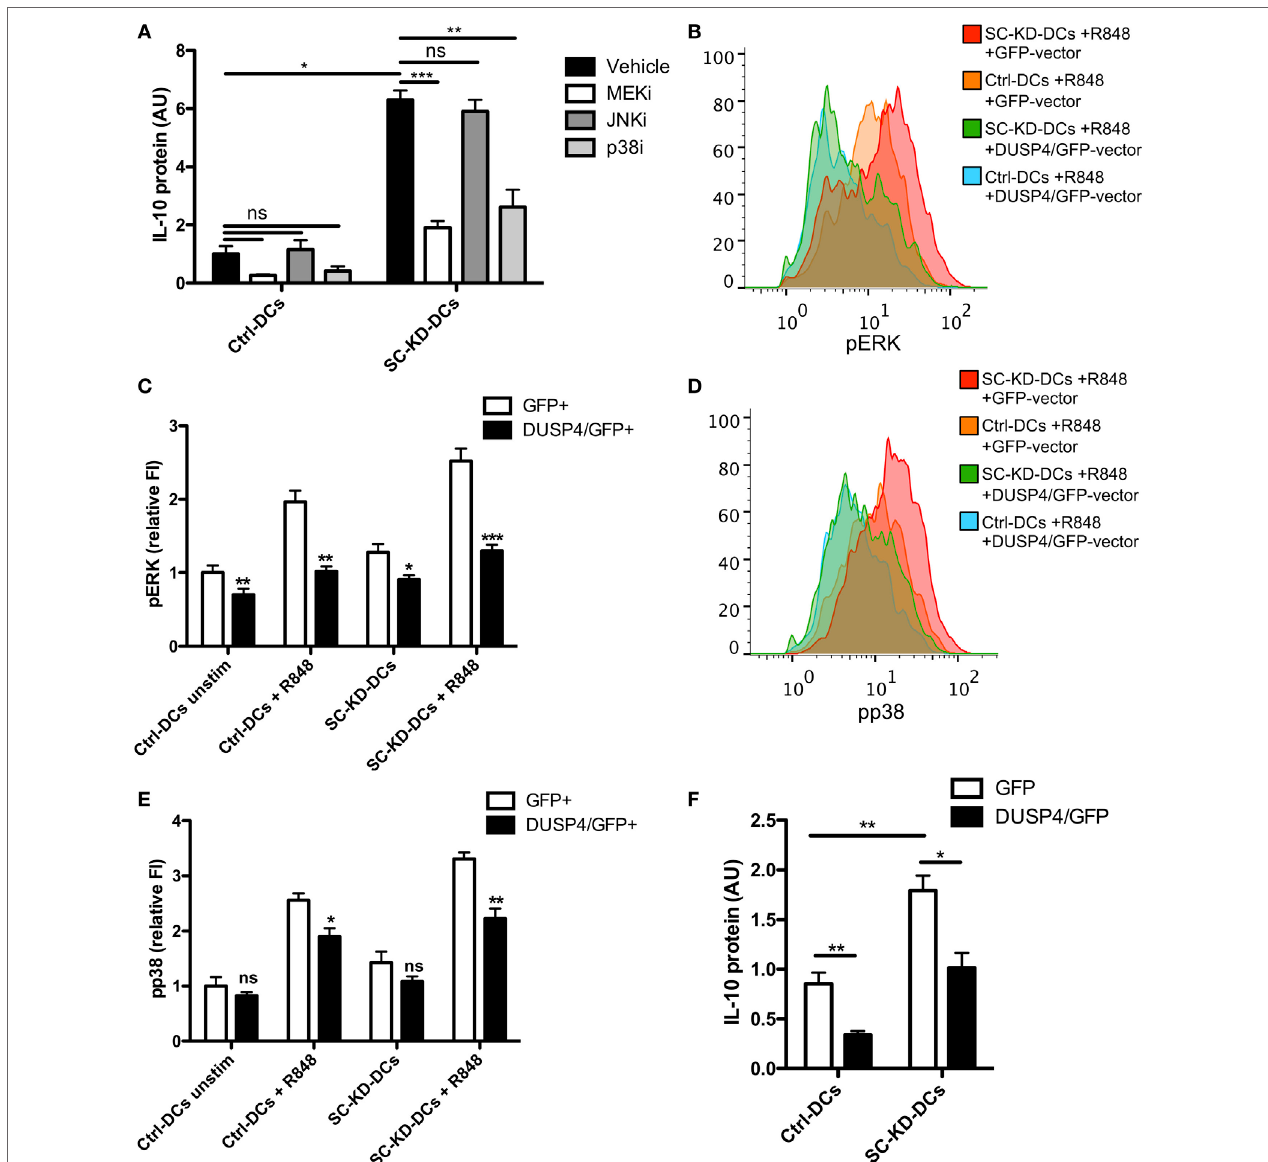
FigUre 4 | DUSP4 expression prevents the DC-SCRIPT-knockdown-mediated change in ERK phosphorylation and IL-10 production. (a) IL-10 protein production by Ctrl-DCs and SC-KD-DCs pre-treated with inhibitors for MEK (upstream of ERK), JNK, p38 or with vehicle control and stimulated with R848 ( n = 6, mean + SEM). (B–e) pERK and pp38 phosphorylation levels of Ctrl-DCs and SC-KD-DCs after overexpression of GFP or DUSP4/GFP by phosphoflow ( n = 8, mean + SEM). (F) IL-10 protein production by Ctrl-DCs and SC-KD-DCs after overexpression of GFP or DUSP4/GFP ( n = 7, mean + SEM). The IL-10 protein data have been normalized to account for donor variation and displayed as arbitrary units (SC-KD-DCs + vehicle range: 0.5–4.6 ng/mL) Statistics: Student’s paired t